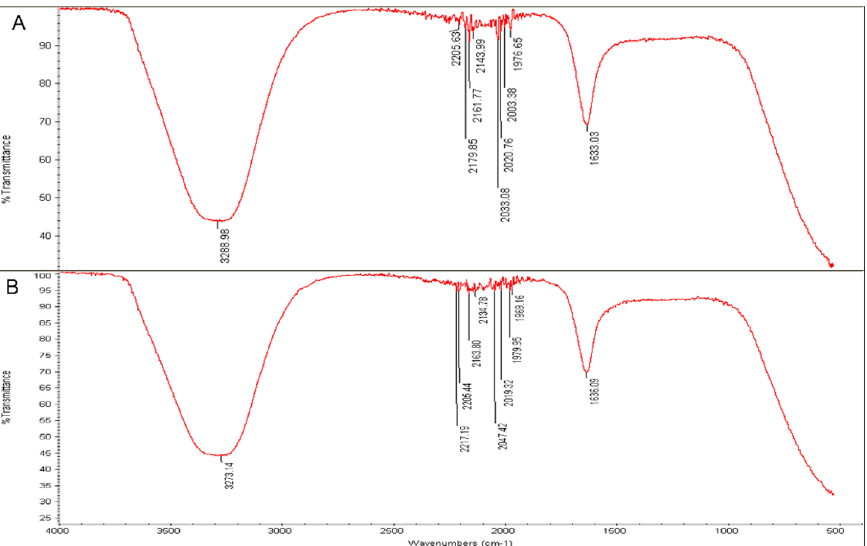
Figure 10. FTIR absorbance peaks of aqueous extracts of R. equisetiformis ( A ) and R-AgNPs ( B ) pre- senting peaks of the extract organic materials.